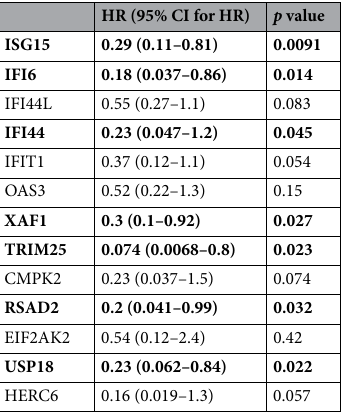
Table 2. Univariable Cox regression for individual hub genes. Hub genes identified by the WGCNA analysed contained within the ‘salmon’ Module 1. Genes in bold have p < 0.05 and were selected for the multivariable Cox/LASSO regression. HR hazard ratio, 95% CI 95% confidence